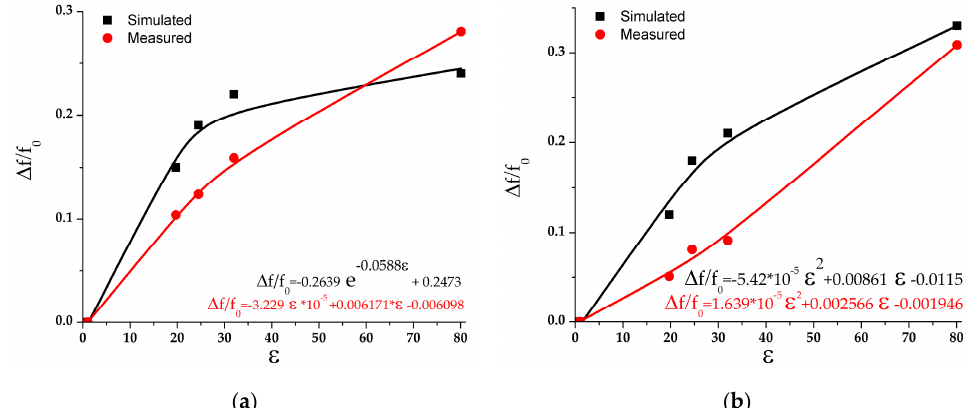
Figure 11. Frequency change ( ∆ f / f 0 ) versus the change of fluid permittivity for: ( a ) Channel 1; ( b ) Channel 2.